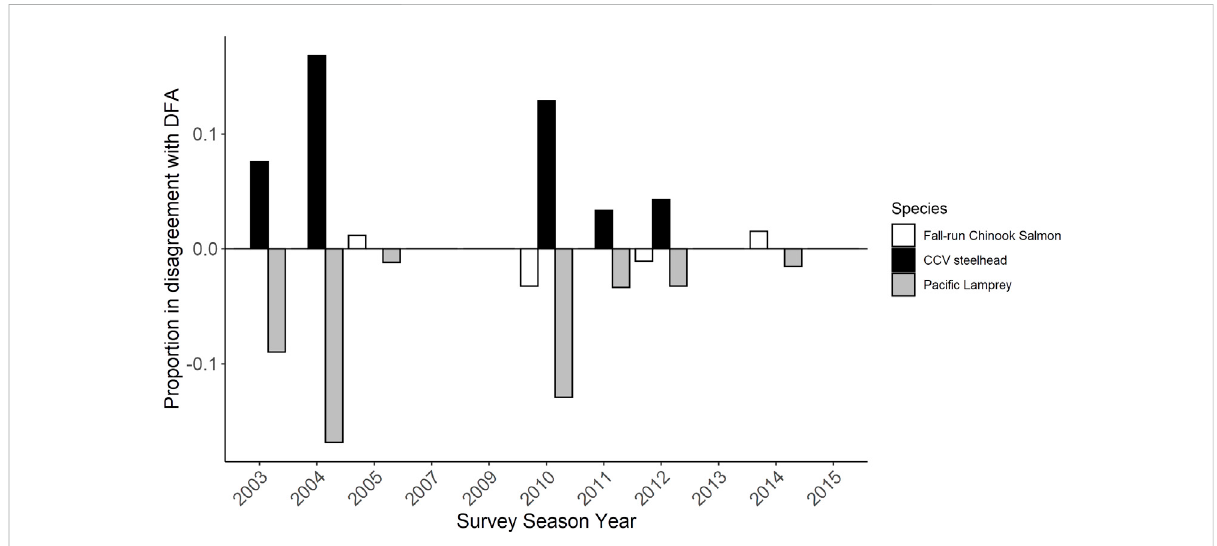
FIGURE 7 The proportion of redd species identi fi cations based on professional opinion that differed from that obtained using the 2021 DFA model. The y axis represents the number of disagreements in redd identi fi cation between professional opinion and the DFA prediction divided by the total redds observed that